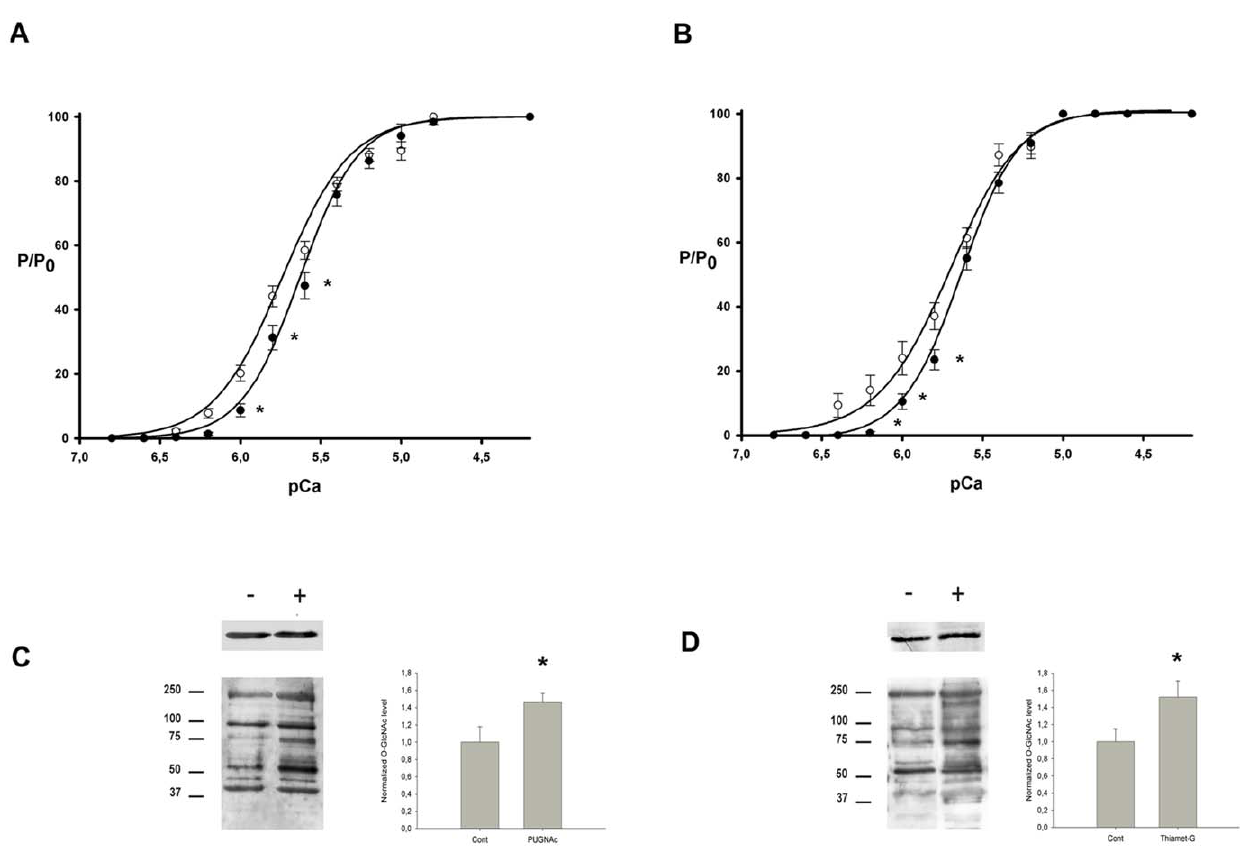
N Figure 1. Effect of the increase of O-GlcNAc level on calcium activation parameters of skinned fibers isolated from soleus. (A) T/pCa N ) and 26 fibers from PUGNAc-treated skinned biopsies ( # ). (B) T/pCa curves were representative of 13 fibers from untreated skinned biopsies ( ) and 7 fibers from Thiamet G-treated skinned biopsies ( # ). Data were curves were representative of 7 fibers from untreated skinned biopsies ( presented as mean 6 SEM. Curves were fitted with the Hill parameters. (C) Proteins from untreated (-) or PUGNAc-treated ( + ) skinned fibers included in T/pCa relationship analysis in A were separated on 10–20% linear gradient gel electrophoresis and analysed on CTD110.6 western blot (below) or actin (above). Three fibers were pooled per lane. (D) Proteins from untreated (-) or Thiamet G-treated ( + ) skinned fibers included in T/pCa relationship analysis in B were analysed by western blot using the CTD110.6 antibody (below) or actin (above). Total densitometry analysis of the western blots was performed and normalized to the control signal for PUGNAC- and Thiamet-G-treated fibers respectively; resulting histograms were presented next to the representative blot image. * indicates significant differences between untreated and treated biopsies (p , 0.05).